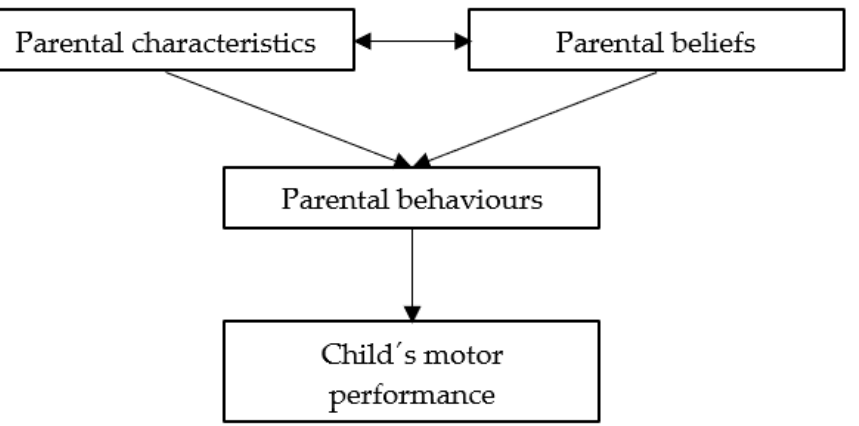
Figure 3. Framework of the relationship between the home learning environment and motor perfor- mance [62].